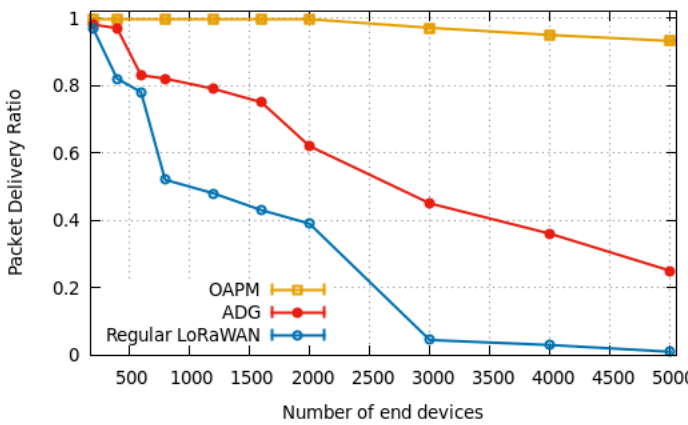
Figure 13. Packet Delivery Ratio of OAPM compared with ADG and regular